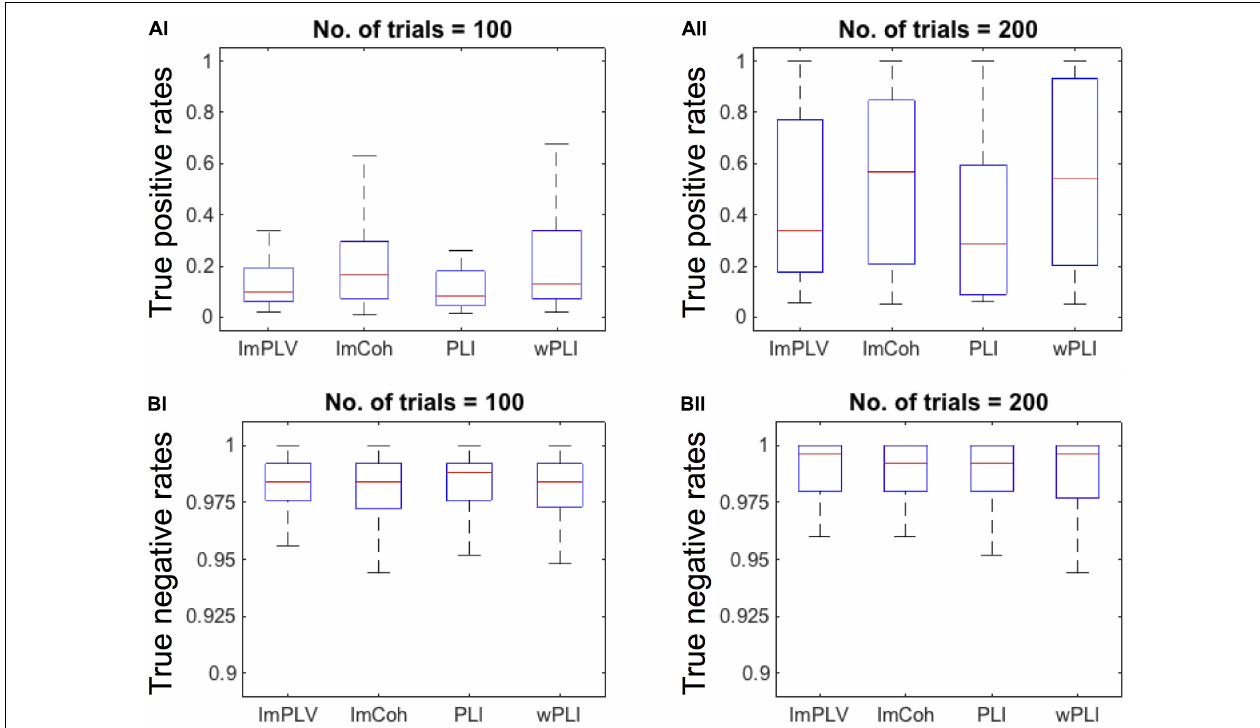
FIGURE 4 | (A) Box plots of the true positive rates (TPRs) with the number of trials being 100 (AI) and 200 (AII) . For this plotting purpose, we only used the datasets ( n = 35) in which the TPRs for the number of trials 200 were above 0.05 across all the FC measures. (B) Box plots of the true negative rates (TNRs) of all the datasets when the number of trials is100 (BI) and 200 (BII) . On each box plot, the red line, the bottom and top edges of the box represent the median, 25th and 75th percentiles of the TPRs, respectively. The whiskers represent the most extreme values of the TPRs except outliers.